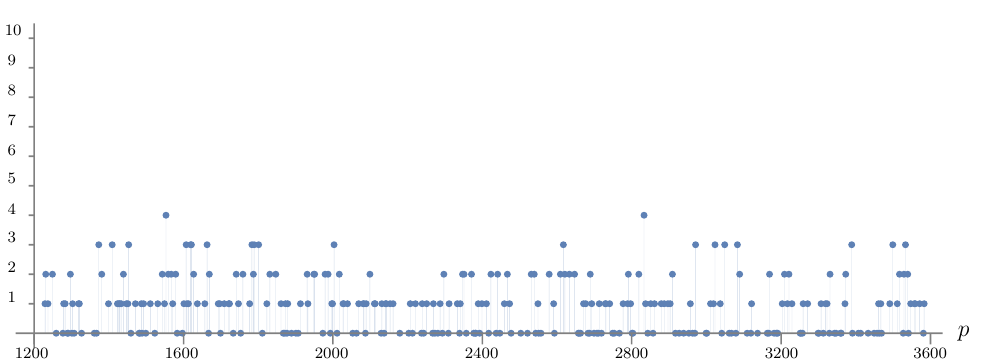
Figure 17 . The frequencies for which there are at least n factorisations for the primes 5 (cid:20) p (cid:20) p max , with increasing p max , in steps of 50 primes. The blue dashed line has height 1 = 2! and the yellow dashed line has height 1 = 3! .